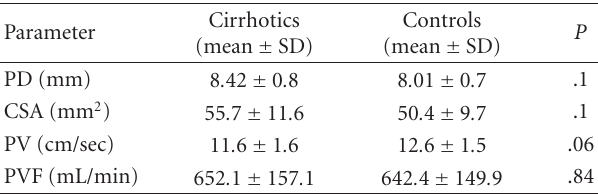
Table 2: Portal US and doppler parameters in cirrhotic patients and healthy controls.